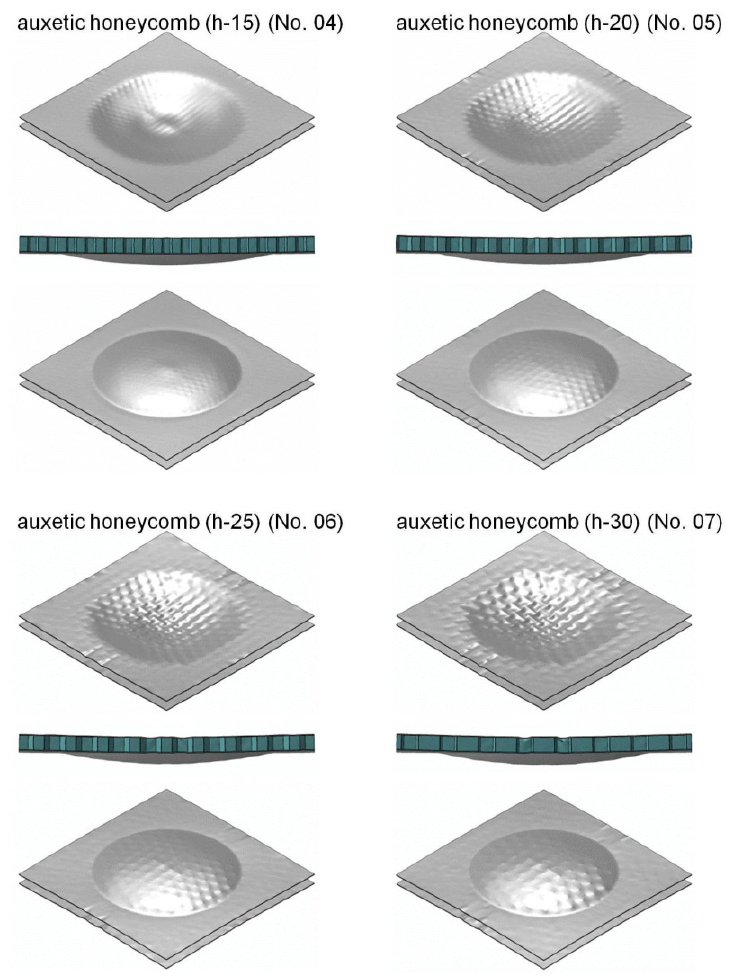
Figure A2. Deformation states of the top and bottom sides for honeycomb cores No. 04–07 subjected to air-blast loading (t = 0.6 ms).